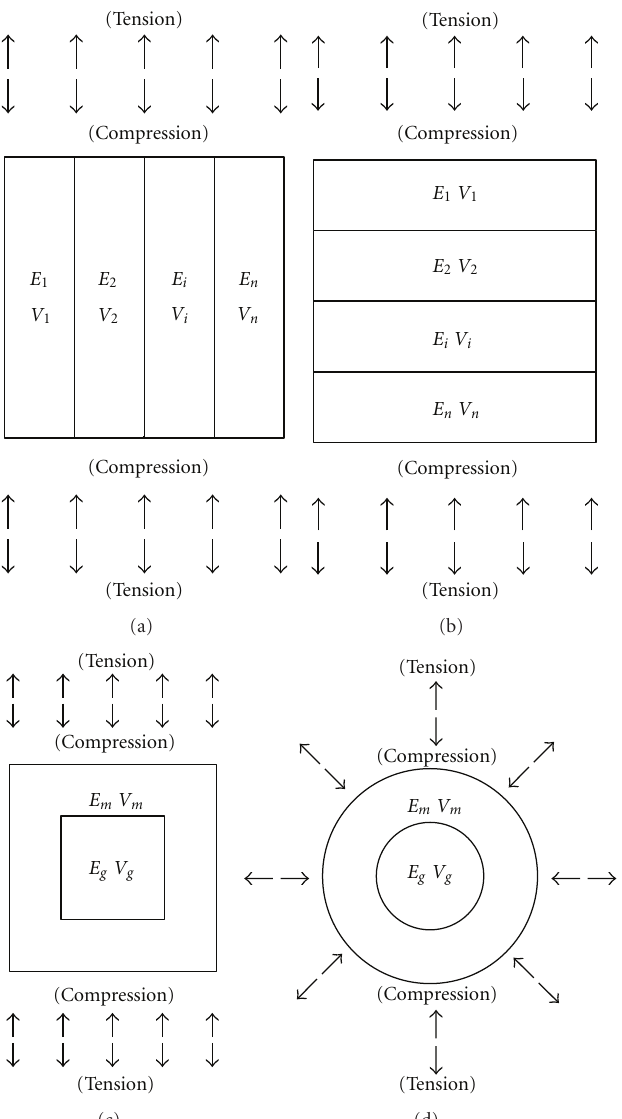
Figure 5: Typical composite models for predicting Young’s modulus: (a) Parallel model, (b) Series model, (c) Counto model, and (d) Hashin